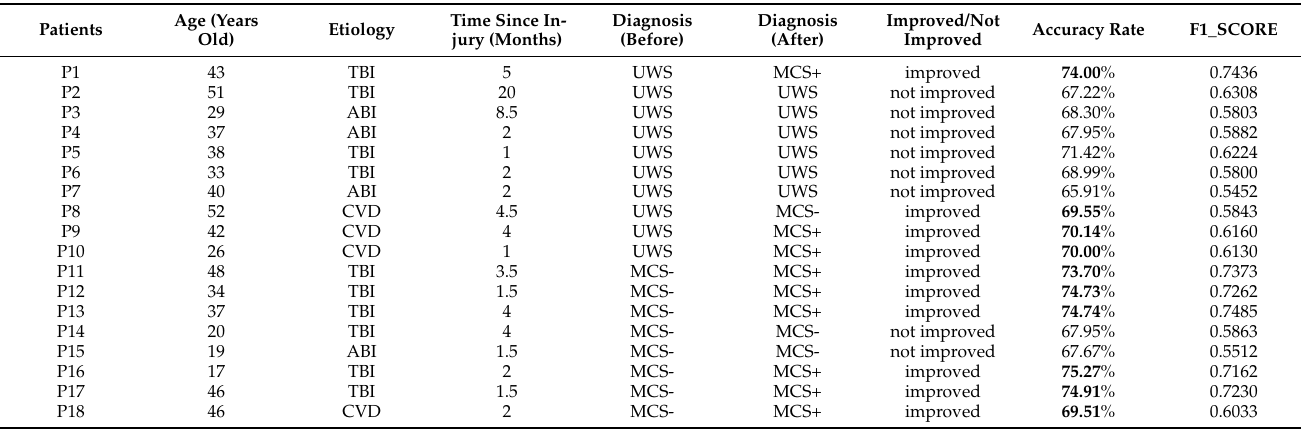
Table 3. Accuracy and F1_score of the P300 detection ( CNN ) for all patients.